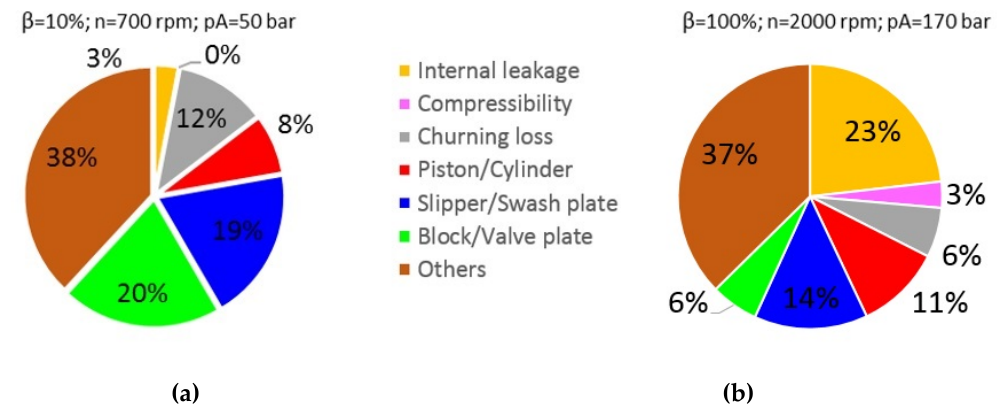
Figure 22. (a) Distribution of power losses at low power operating condition and θ B = 70 °C; (b) Figure 22. ( a ) Distribution of power losses at low power operating condition and θ B = 70 ◦ C; distribution of power losses at high power operating condition and θ B = 70 °C. ( b ) distribution of power losses at high power operating condition and θ B = 70 ◦ C.